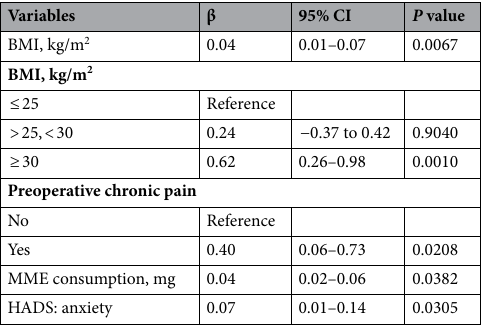
Table 2. Multivariate analysis of predictors for APSP trajectory intercept. APSP Acute presurgical pain , BMI body mass index, MME morphine milligram equivalent, HADS Hospital Anxiety and Depression Scale.